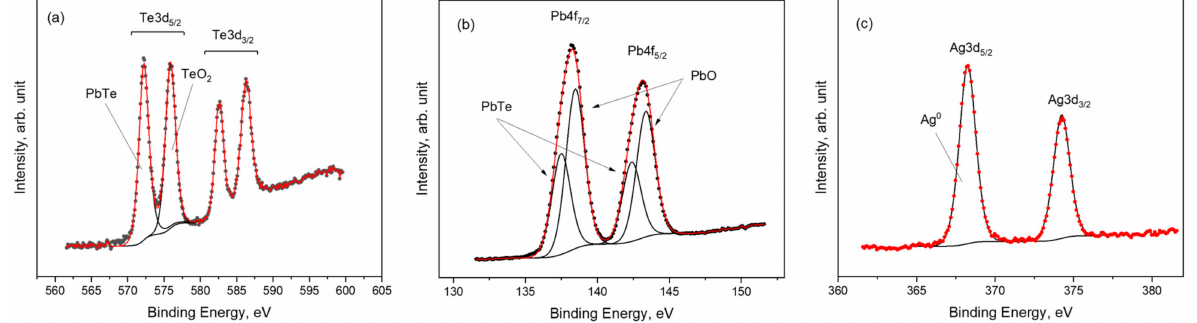
Figure 1. Te3d ( a ), Pb4f ( b ), and Ag3d ( c ) spectra acquired by the investigation of the sample PbTe10.